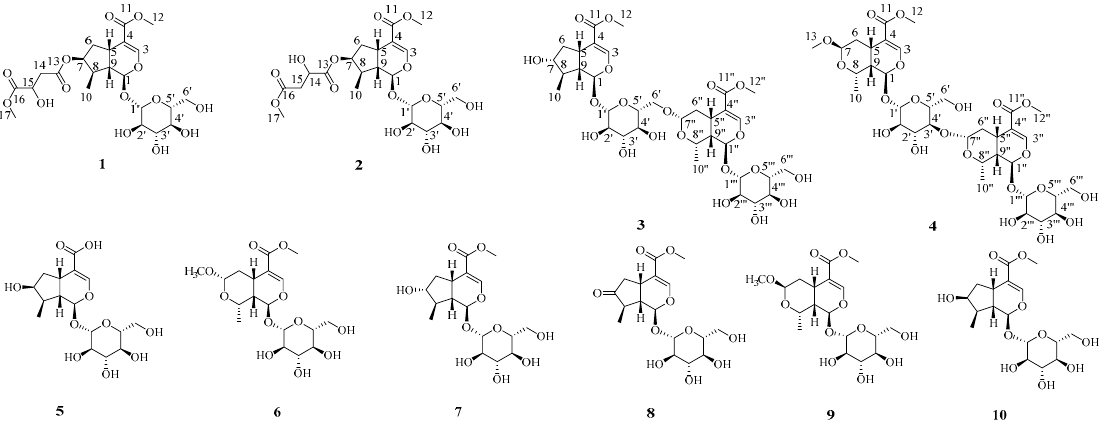
Figure 1. Chemical structures of compounds 1 – 10 isolated from the fruits of Cornus officinalis.